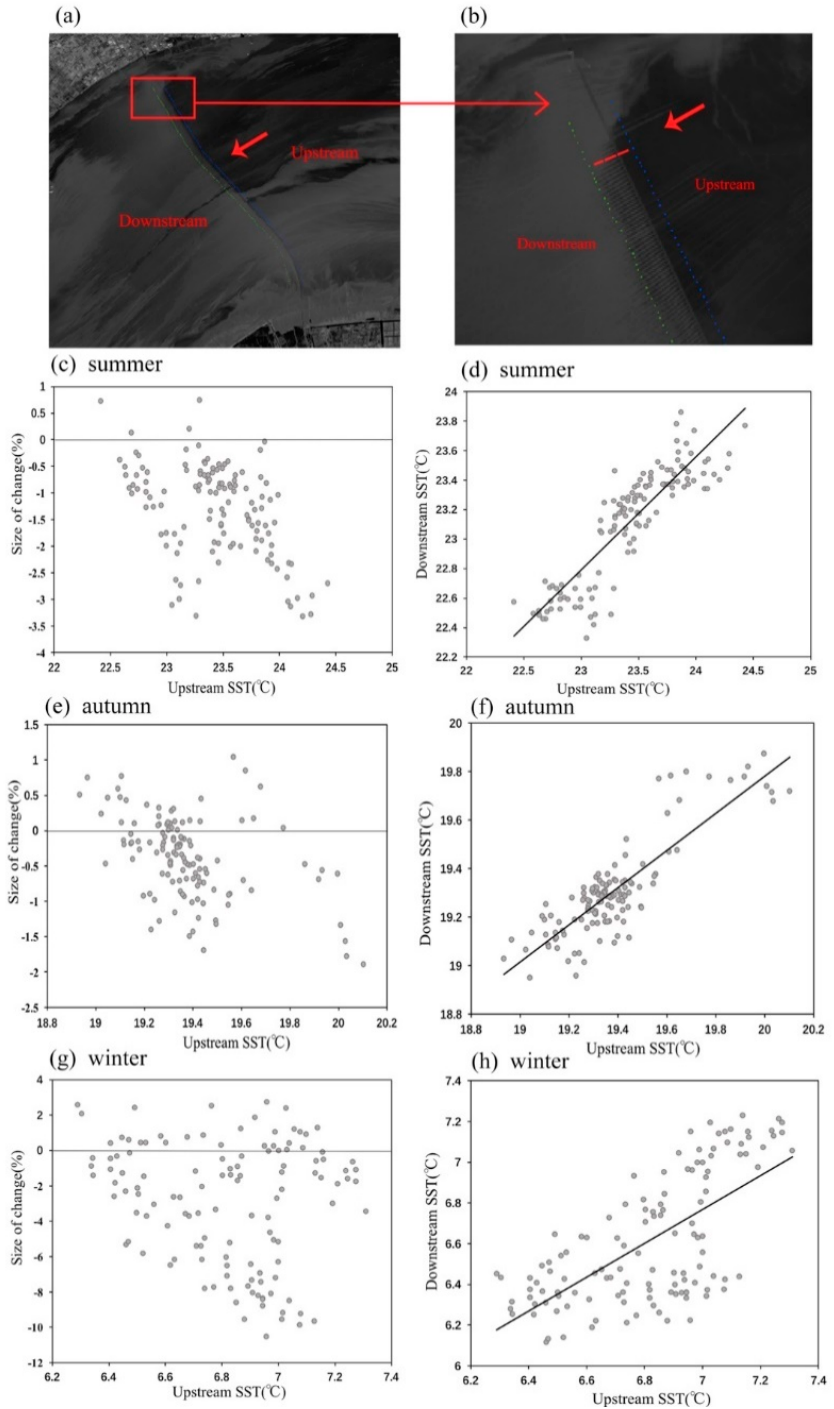
Figure 5. ( a , b ) Distribution of sampling points. ( c , e , g ) Regression analysis between upstream SST and change in SST downstream during rising and ebbing tides. Formula is (upstream SST − downstream SST) / (upstream SST) × 100%. Positive values denote SST increases, and negative values denote SST decreases. ( d , f , h ) Regression analysis of upstream and downstream SSTs during rising and ebbing tides.